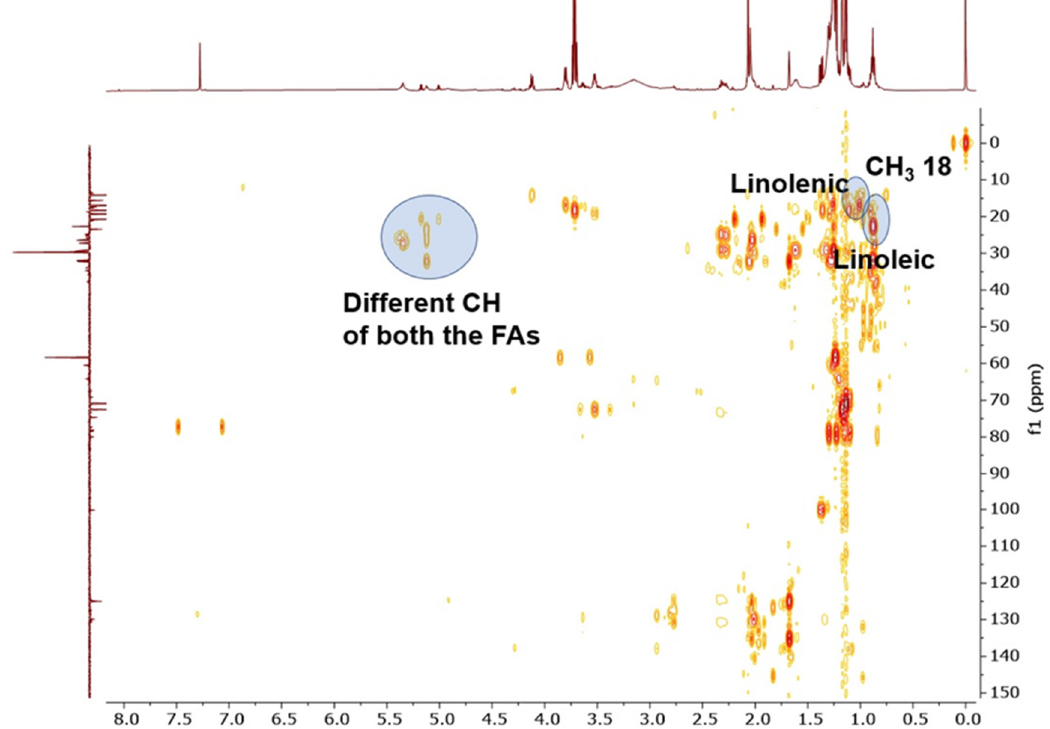
Figure 2. Heteronuclear single quantum correlation (HSQC) analysis of diethyl ether extracts of saffron stamens.